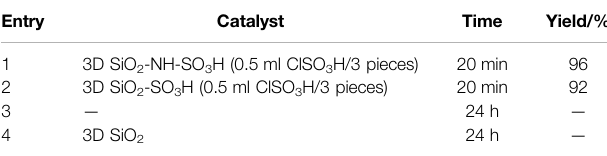
TABLE 2 | Comparison of catalytic ef fi ciency for different sulfonated catalysts.